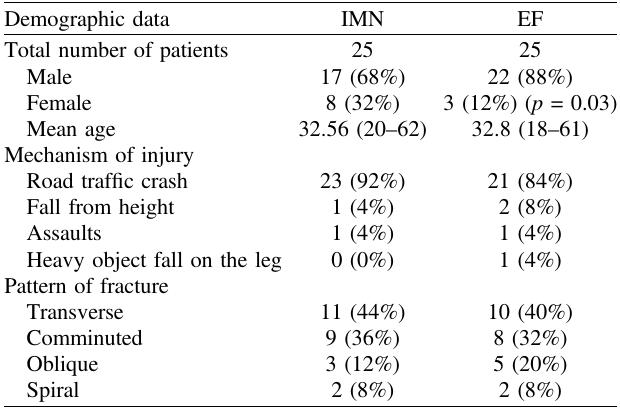
Table 1. Demographic data.